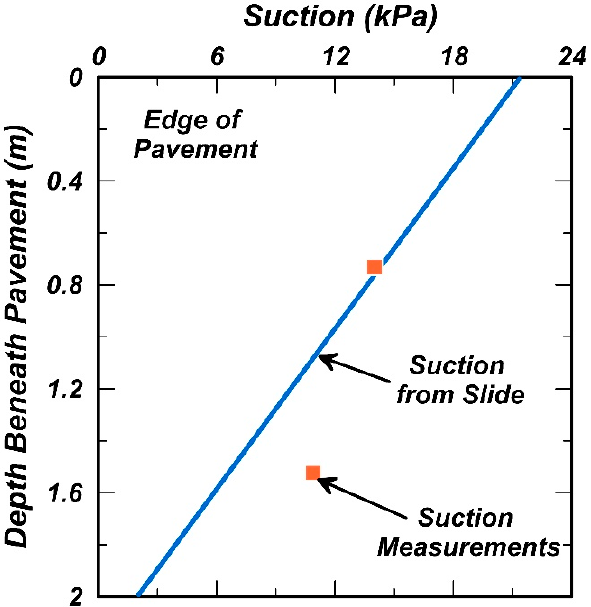
Figure 13. Suction values in the slope stability analyses and in-situ suction measurements from borehole sensors near the edge of pavement.